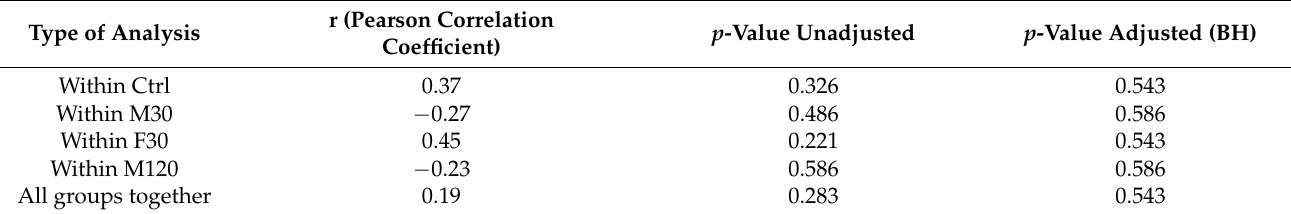
Table 4. Correlation between serum IL-10 [pg/mL] and EL [pg/mL]